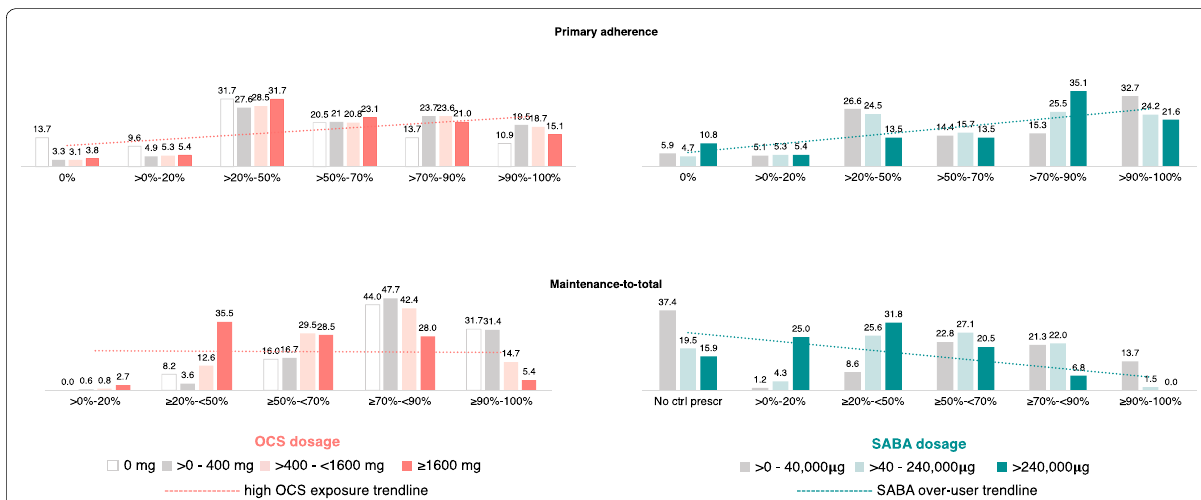
Fig. 2 Frequency (%) of SABA users and OCS users on persistent respiratory treatment, by primary adherence to controller medication and ratio